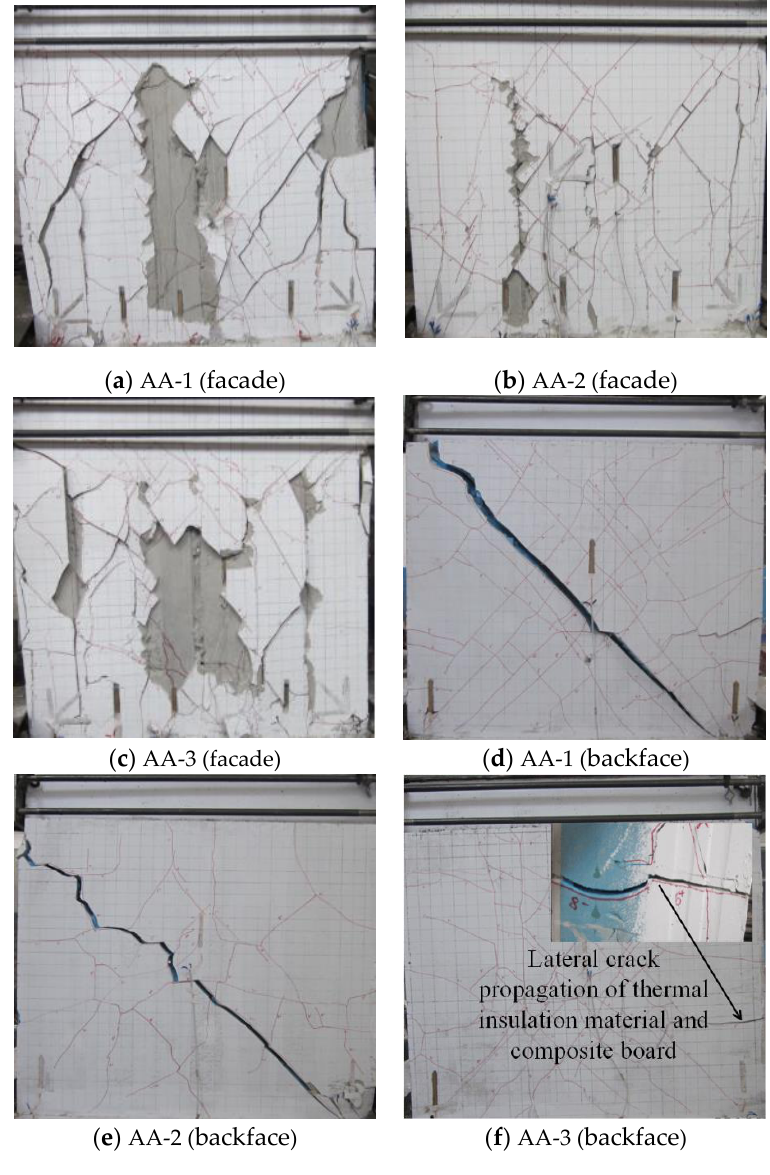
Figure 6. Specimen fracture morphology.